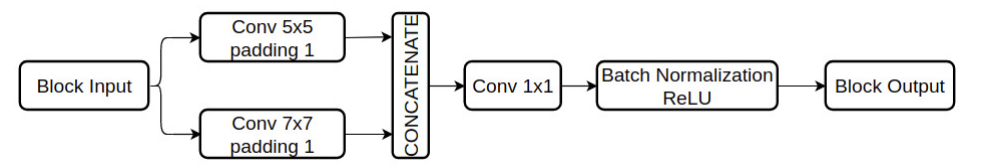
Figure 3. The proposed method.